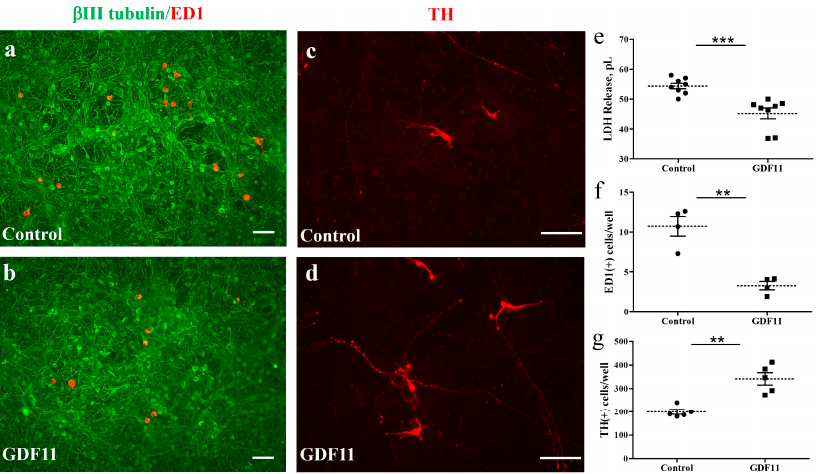
Figure 1. GDF11 enhanced neuronal survival but reduced microglial numbers in neuron–glial cultures. ( a , c ) Control cells; ( b , d ) GDF11-treated cells. Cells in ( a , b ) are immunoreactive (IR) for β III tubulin (in green) and for ED-1 (in red) and are neurons and microglia, respectively. Magnification: 100 × . Cells in ( c , d ) are tyrosine hydroxylase (TH)-IR dopaminergic neurons. Magnification: 200 × . ( e ) Quantification of lactate dehydrogenase (LDH) release in the culture medium of ( a , b ). ( f ) Quantification of ED-1-IR microglia per 0.01516 cm 2 in the cultures of ( a , b ). ( g ) Quantification of TH-IR cell numbers per well (1.131 cm 2 ) in the cultures of ( c , d ) from representative images. The results are reported as mean ± SEM in each group from three to four independent experiments. ** p < 0.01, *** p < 0.001 Control versus GDF11 treatment, by unpaired Student t -test. Magnification: 100 × in ( a , b ) and 200 × in ( c , d ). Scale bar: 100 µ m.